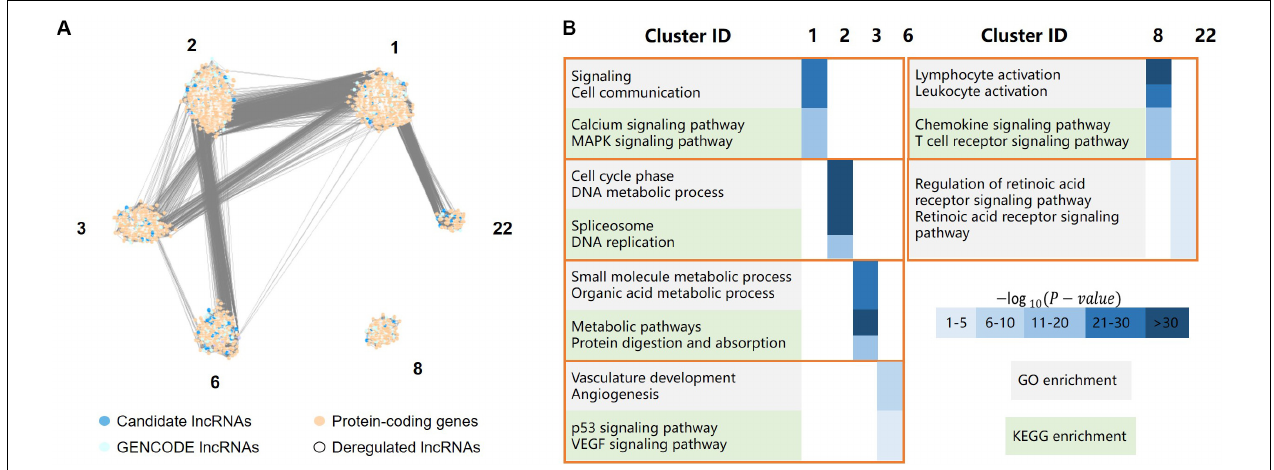
FIGURE 4 | LncRNA functional analysis, including a total of 4,737 protein-coding genes, 701 GENCODE-annotated lncRNAs, and 413 candidate lncRNAs, the protein-coding genes and lncRNAs were clustered in six clusters. (A) The major clusters of the protein-coding gene/lncRNA coexpression network, where dark and light blue dots represent lncRNAs, light orange dots represent protein-coding genes, white dots represent deregulated lncRNAs. (B) GO/KEGG enrichment of the six major clusters, in which cluster 1 was mainly involved in cell signaling, cluster 2 was mainly involved in cell cycle processes, cluster 3 mainly related to the metabolic process in the stomach, cluster 6 was mainly involved in angiogenesis, cluster 8 was mainly involved in the immune response, and cluster 22 was primarily associated with the retinoic acid (RA) receptor signaling